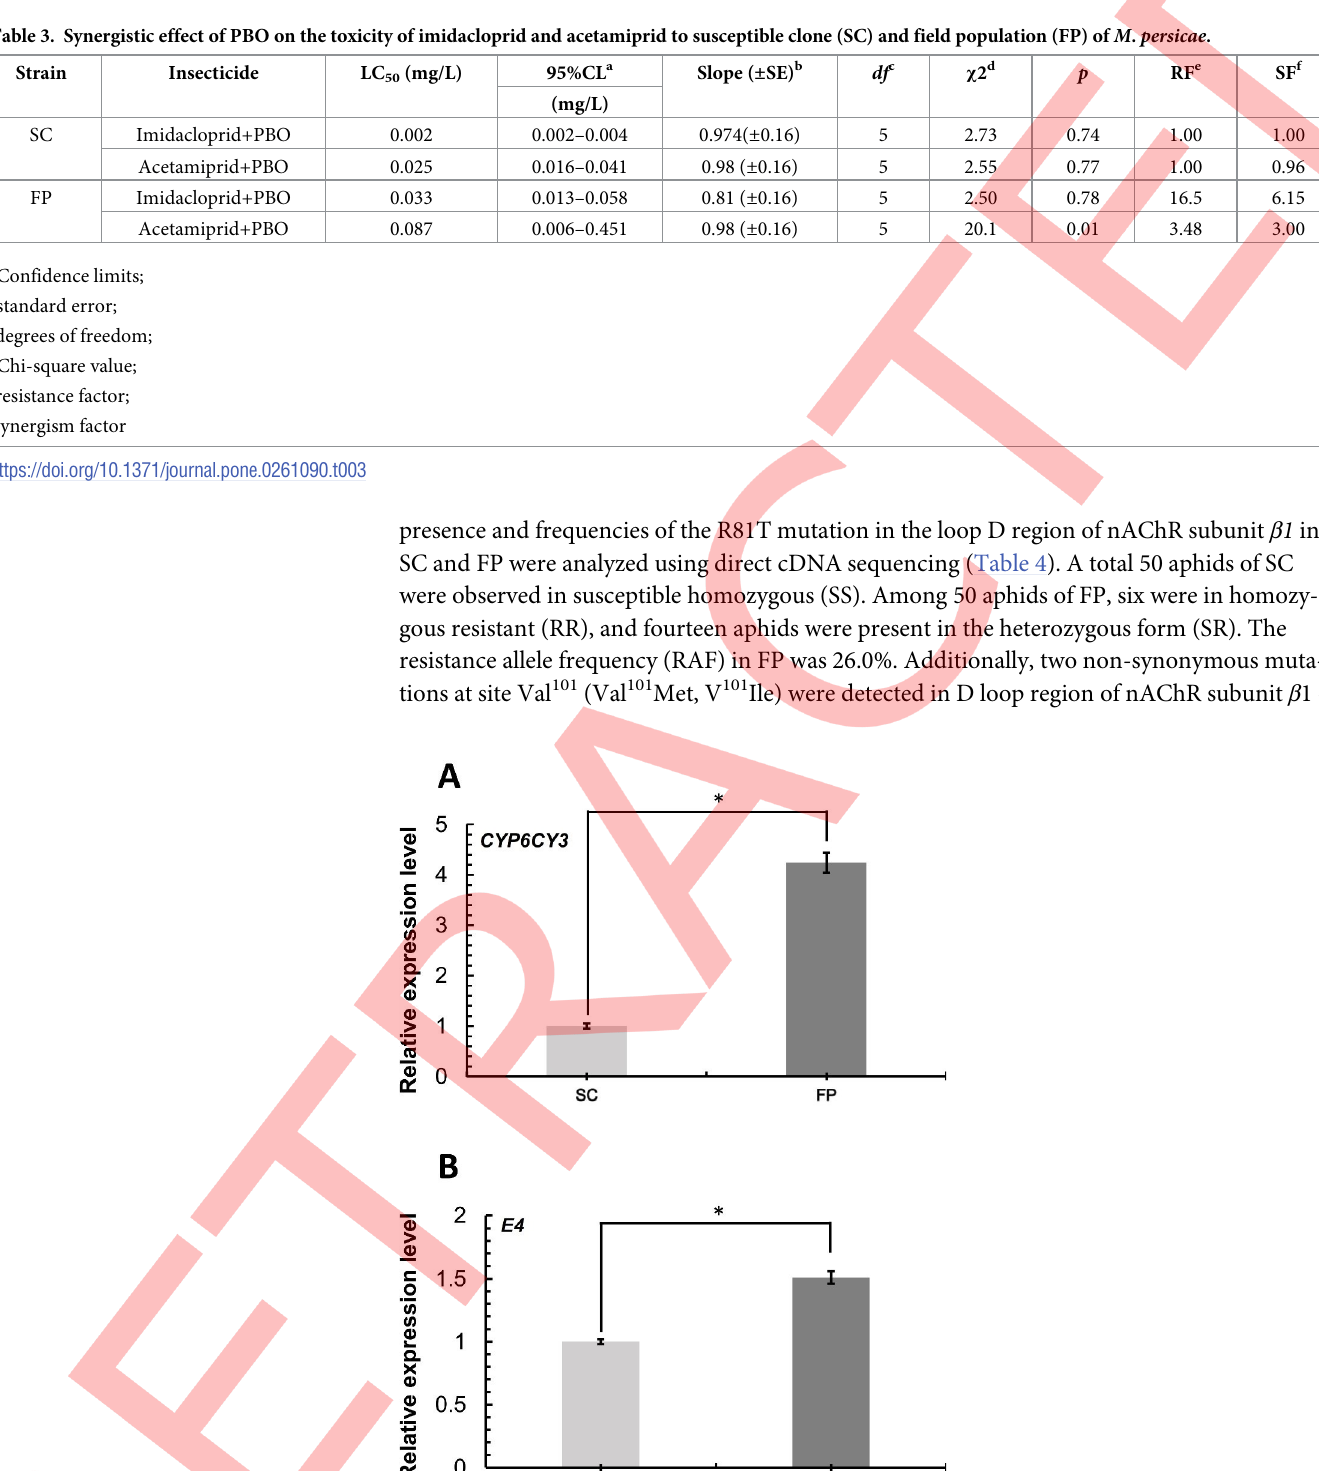
Fig 1. Relative mRNA transcriptional levels of (A) cytochrome P450 CYP6CY3 and (B) E4 in susceptible clone (SC) and field population (FP) of Myzus persicae . Data are presented as means ± SE from three independent experiments for each strain. The symbol ( � ) is used to denote significant difference ( p <